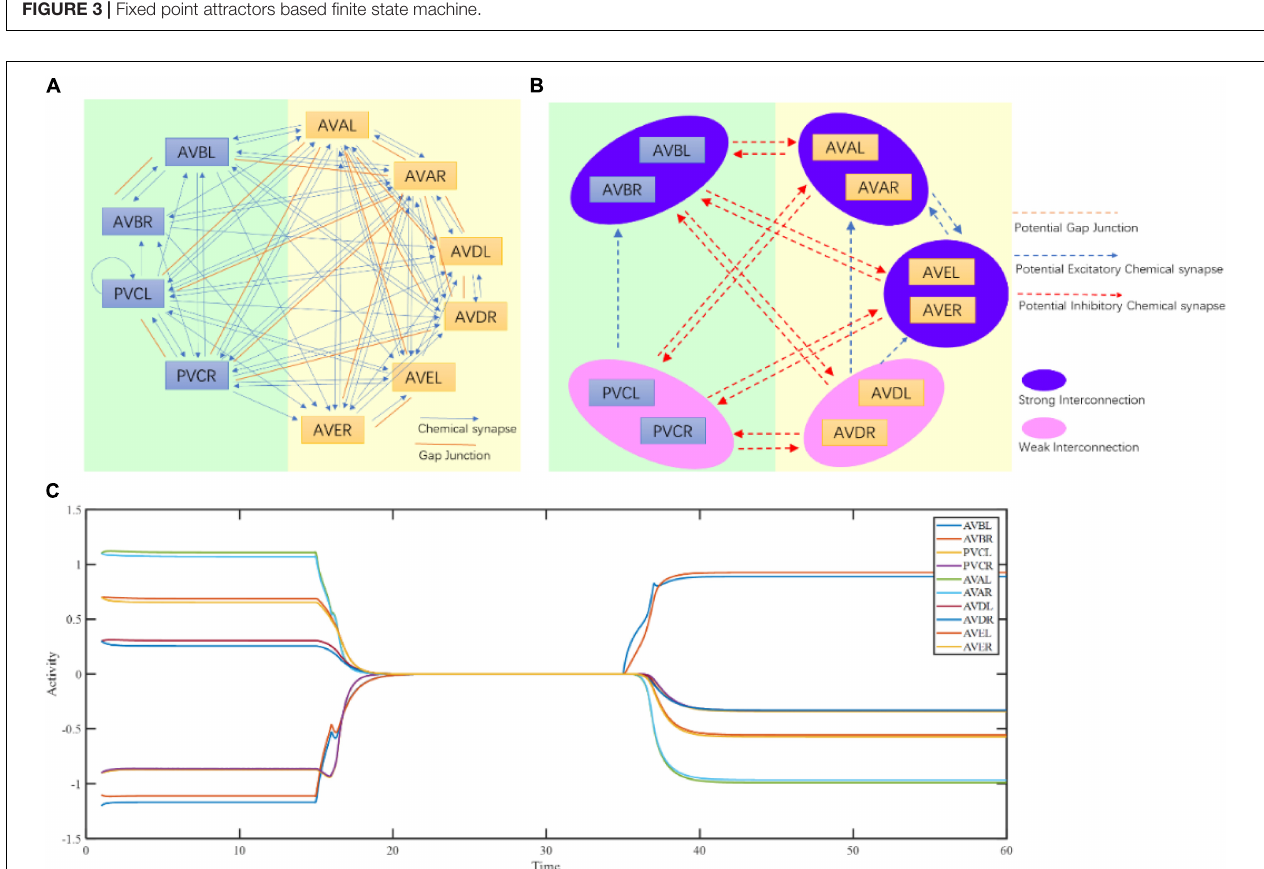
FIGURE 4 | Command circuit of C. elegans. (A) Connectome of command circuit. (B) Implicit structure deduction of command circuit. (C) Three fixed points of the command circuit calculated by Equation (3).